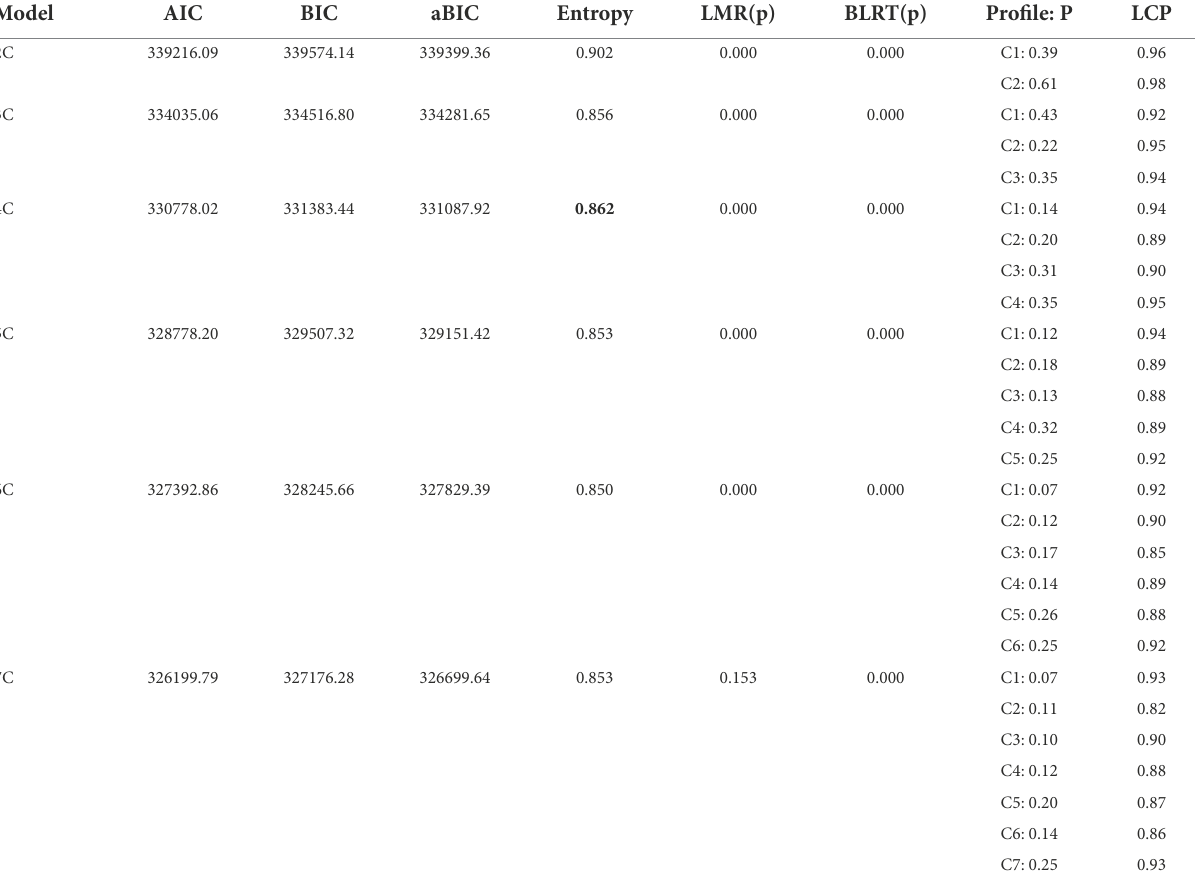
TABLE 3 Model fits for optimal number of profiles in latent profile